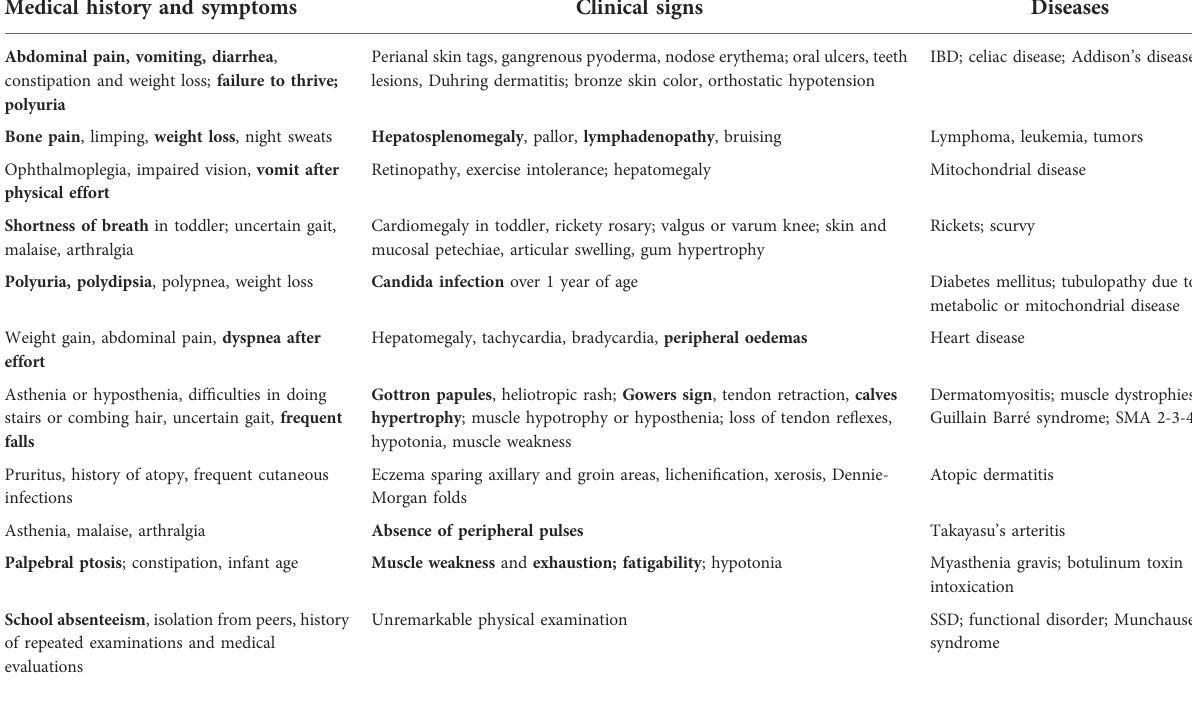
TABLE 1 Red fl ags to search for in a child complaining of fatigue . Abbreviations: IBD, intestinal bowel disease; SSD, somatic symptom disorder; SMA, spinal muscular atrophy. Medical history and